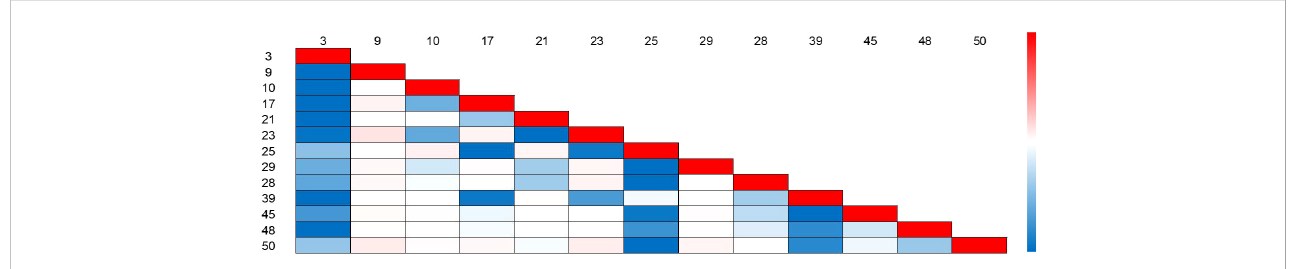
FIGURE 4 Internal dHash similarity of Lepidoptera support instances in the FSIP52 data set. The redder the heat map color block, the higher the visual